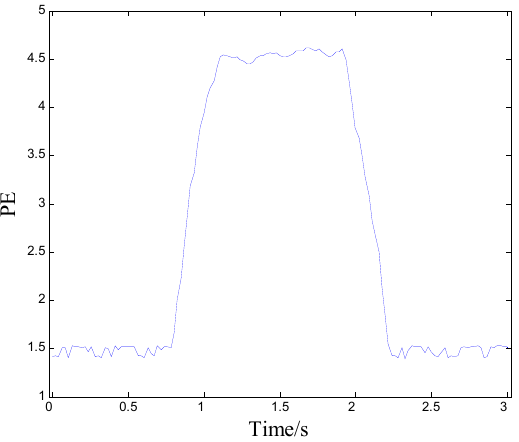
Figure 22. PE values of noisy FM signal along with time.